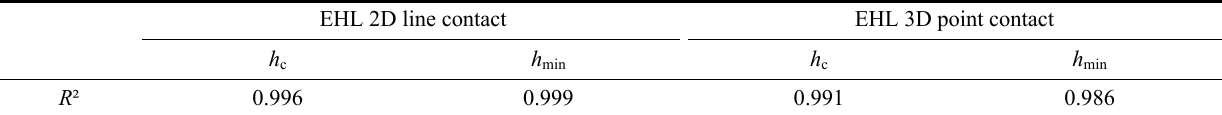
Table 4 Coefficients of determination of the analytically solved proximity equations for the central and minimum film thickness for the infinite 2D line and 3D circular point contacts, respectively.